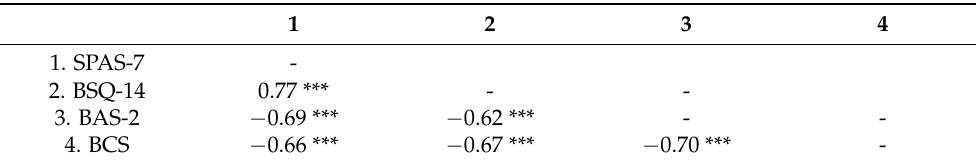
Table 4. Bivariate Correlations Between Social Physique Anxiety, Body dissatisfaction, Body Appreci- ation, and Body Compassion ( N =